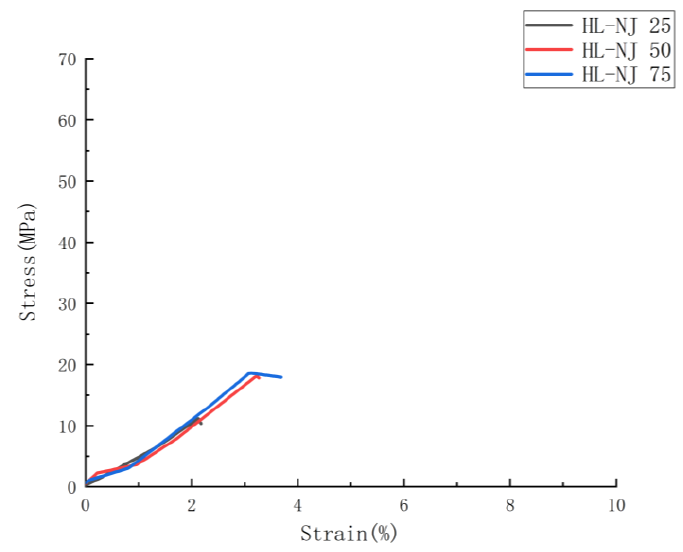
Figure 6. Average stress-strain curves for HL-NJ series in function of infill density.